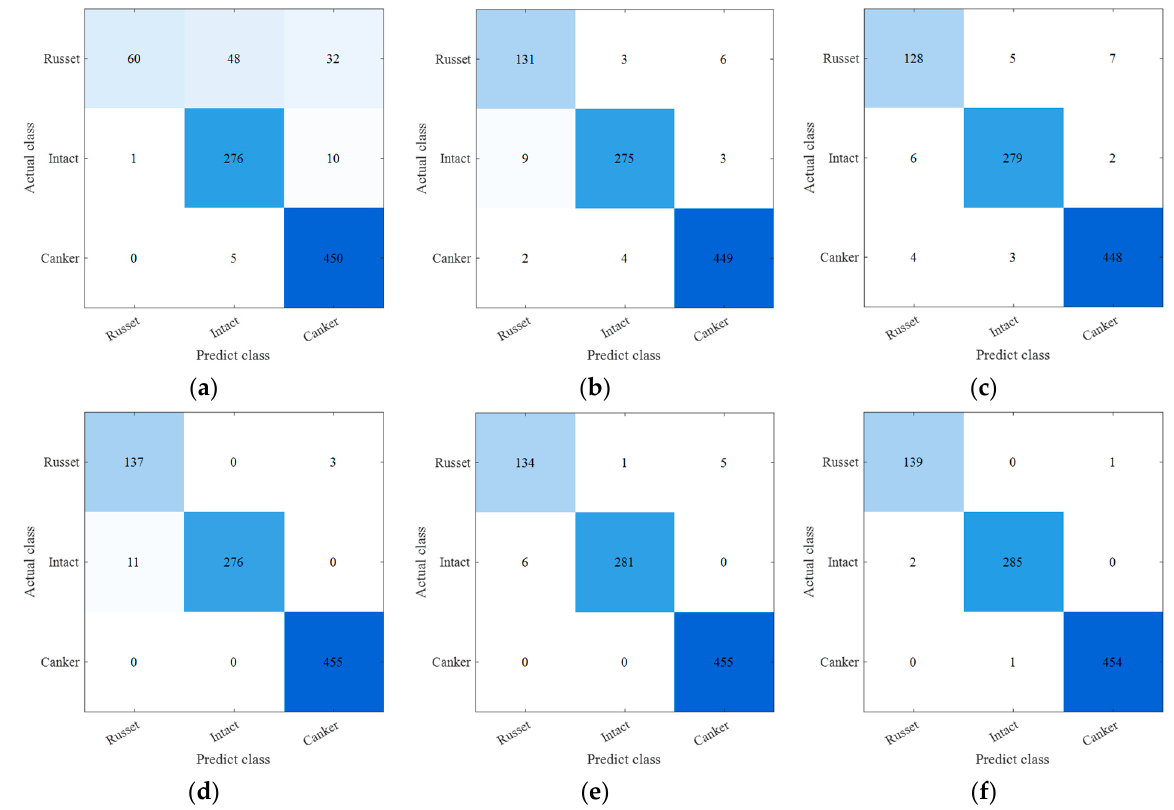
Figure 5. Confusion matrix based on different loss functions: ( a ) SGM-CE; ( b ) SM-CE; ( c ) FL; ( d ) CB-SGM-CE; ( e ) CB-SM-CE; ( f ) CB-FL.